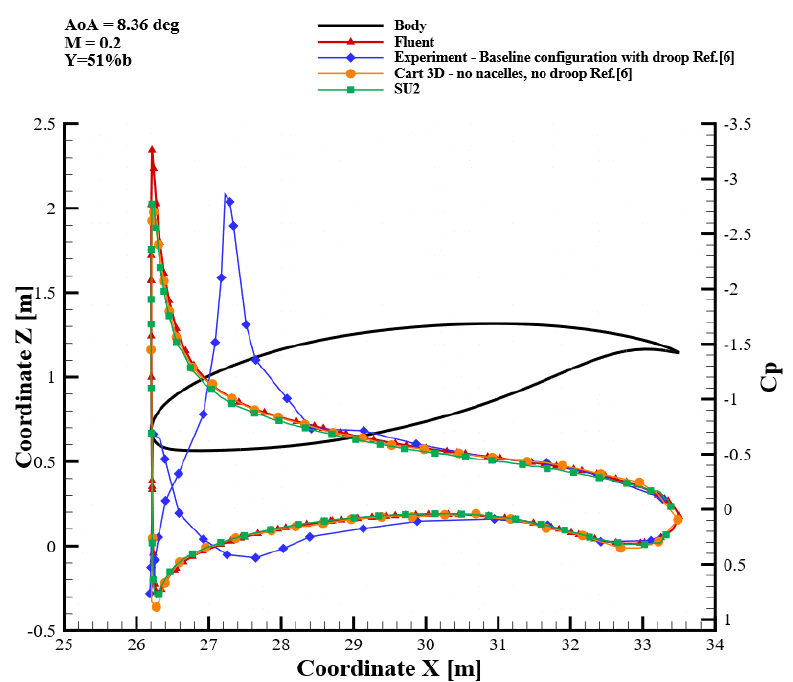
Figure 18. Chordwise pressure distribution at β = 51.0%, comparison between present results and literature